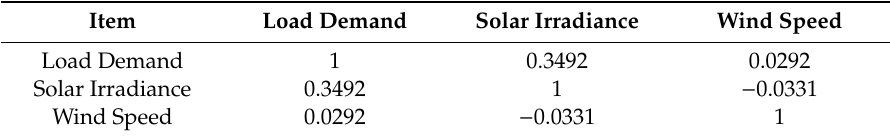
Table 1. Correlation coe ffi cient of load, solar irradiance, and wind speed.